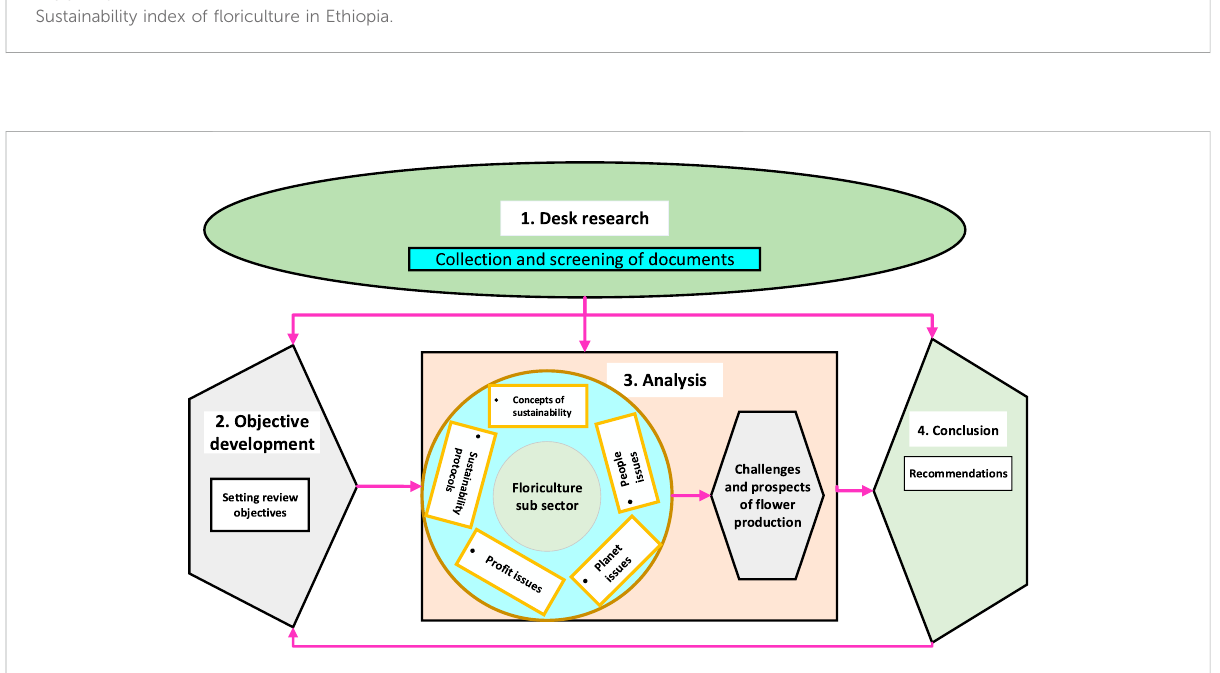
FIGURE 6 Sustainability index of fl oriculture in Ethiopia.